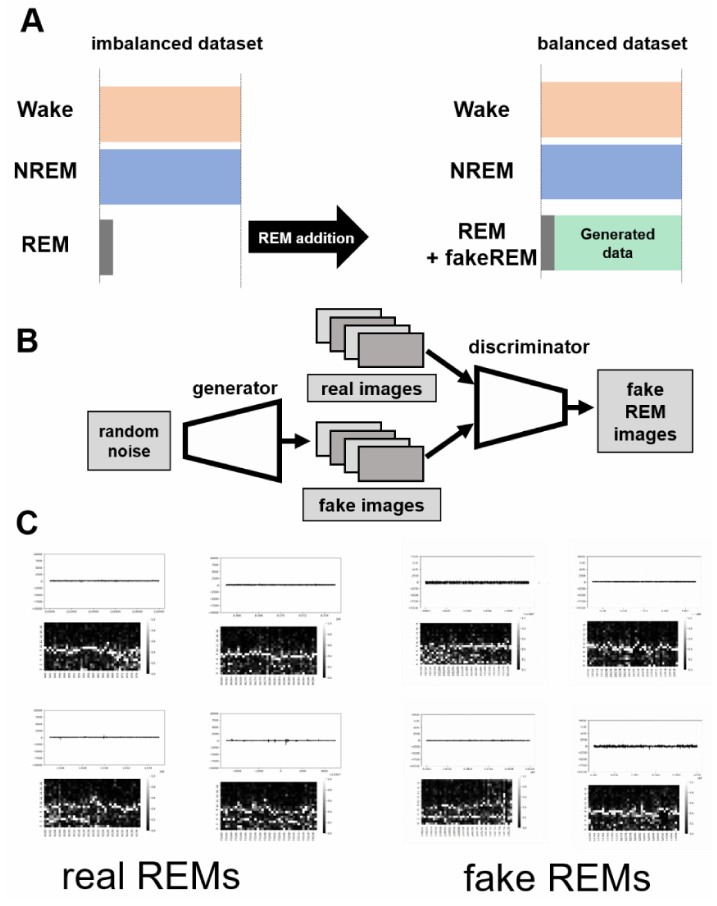
Figure 3. Expansion of the dataset using fake images. ( A ) Schematic representation of WGAN-GP-based image expansion. Bottom left shows the true image and the bottom right is the fake image generated based on the dataset. ( B ) Modified DCGAN (deep convolutional generative adversarial network) structure. High-resolution images (512 × 512) will be generated in our model. ( C ) Real REM sleep and fake REM